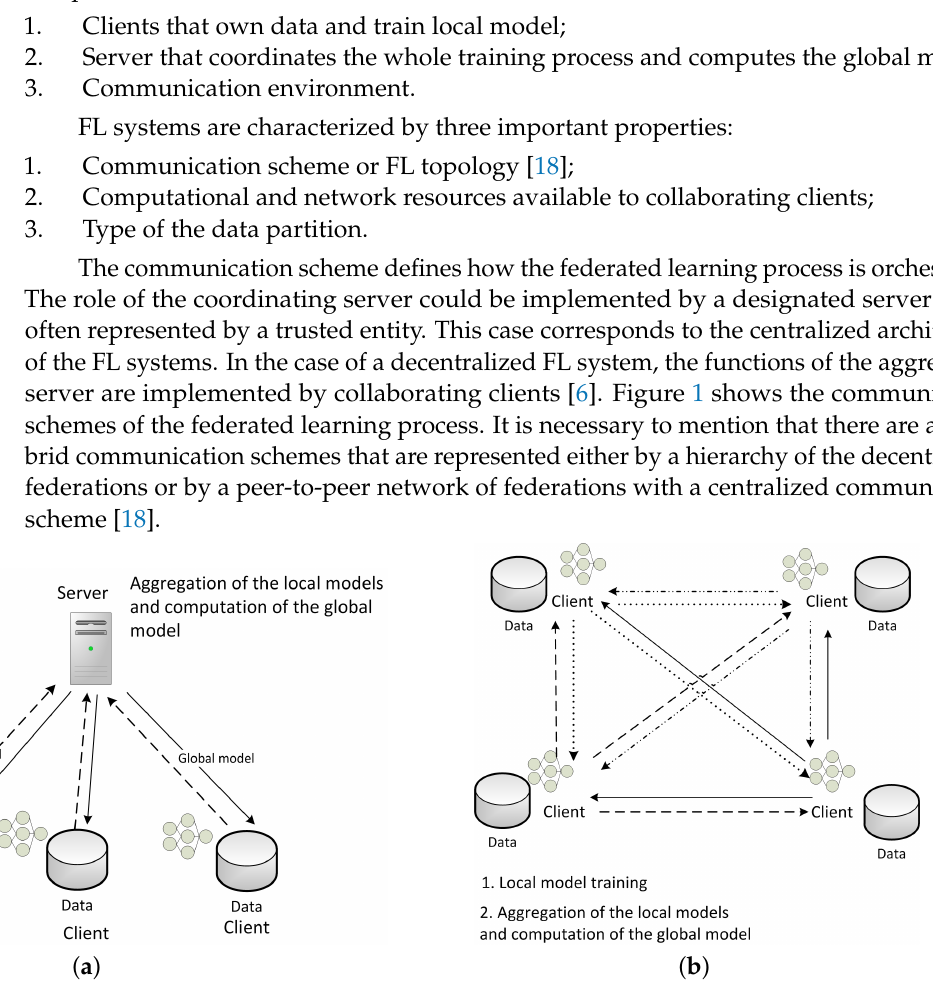
Figure 1. Overview of the communication scheme in FL systems: centralized communication topology ( a ), decentralized communication topology ( b